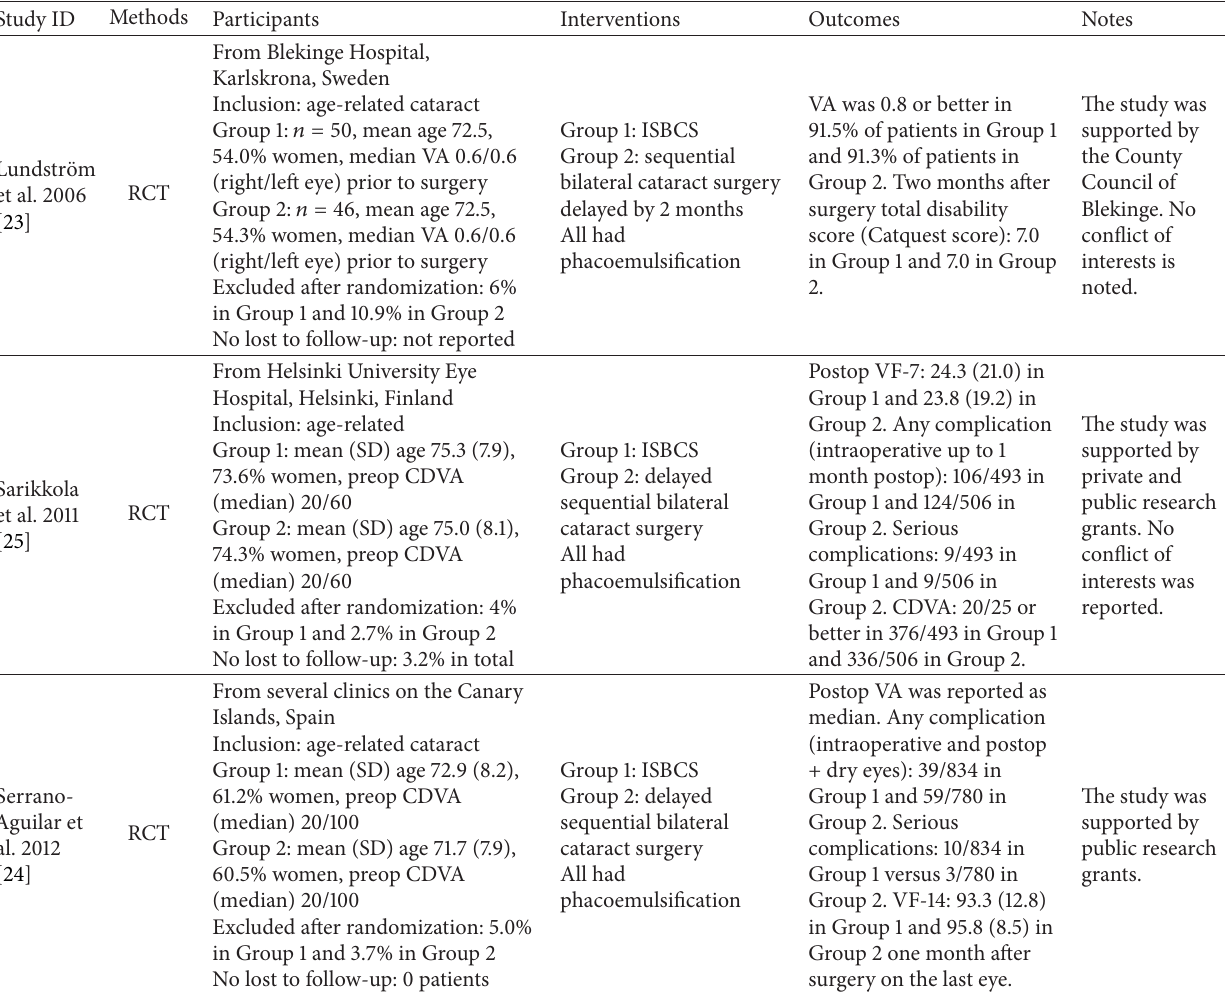
Table 1: Characteristics of included